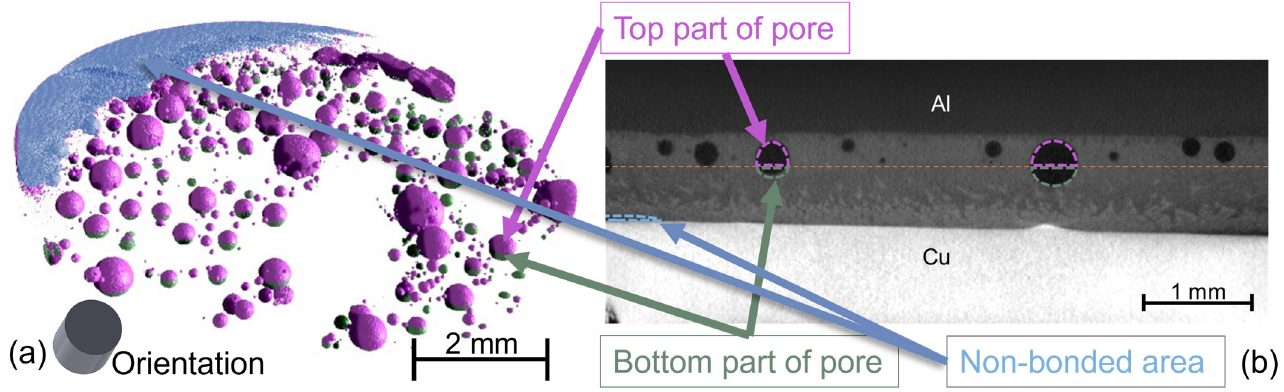
Figure 8. Compound image: ( a ) Defect volume in the whole sample with high porosity and non- bonded areas, ( b ) 2D XRM image of the same sample at y = 5.33 mm showing porosity and non- bonded area.